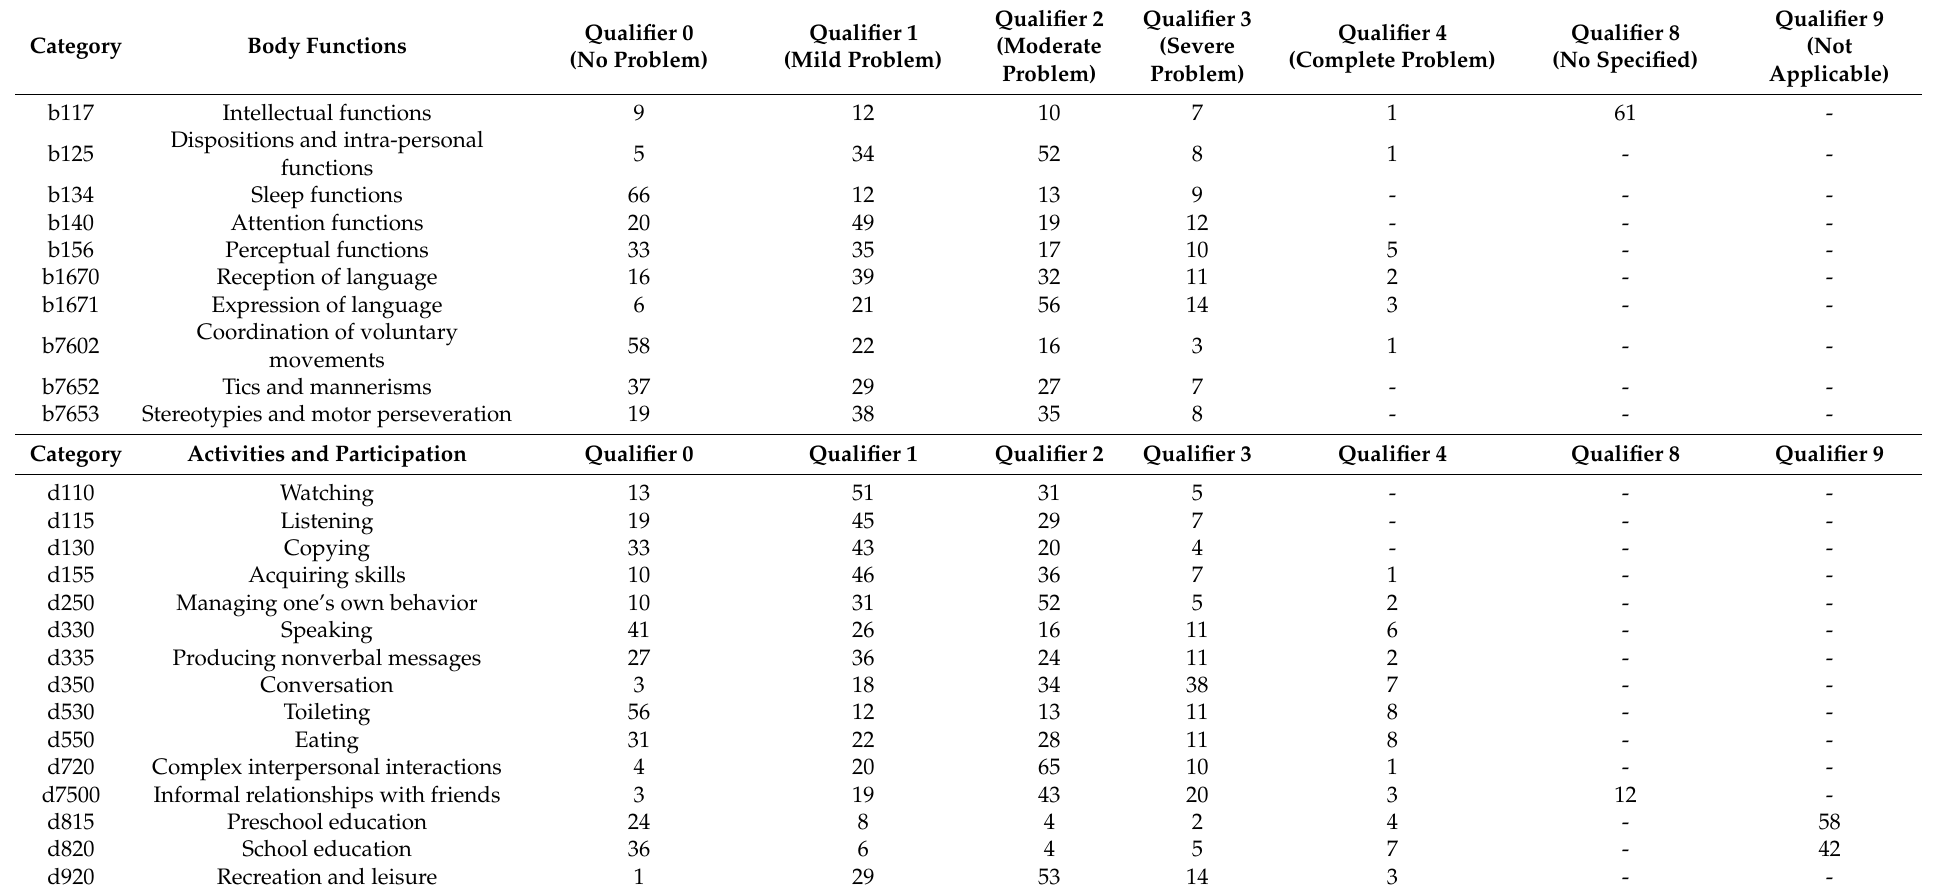
Table 3. Frequency (%) of impairment, limitations/restrictions, barrier or facilitator in body functions, activities and participation and environmental factors, ( n = 100 children with ASD).